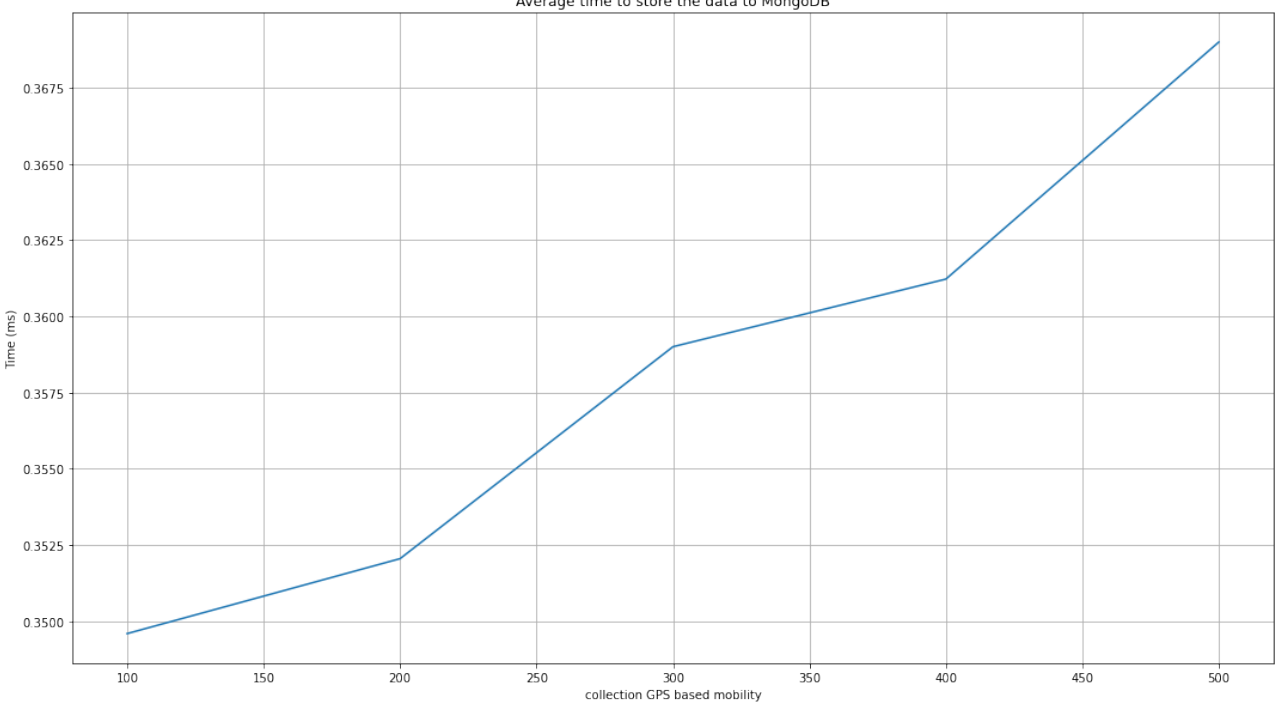
Figure 9. The average time to store the data to